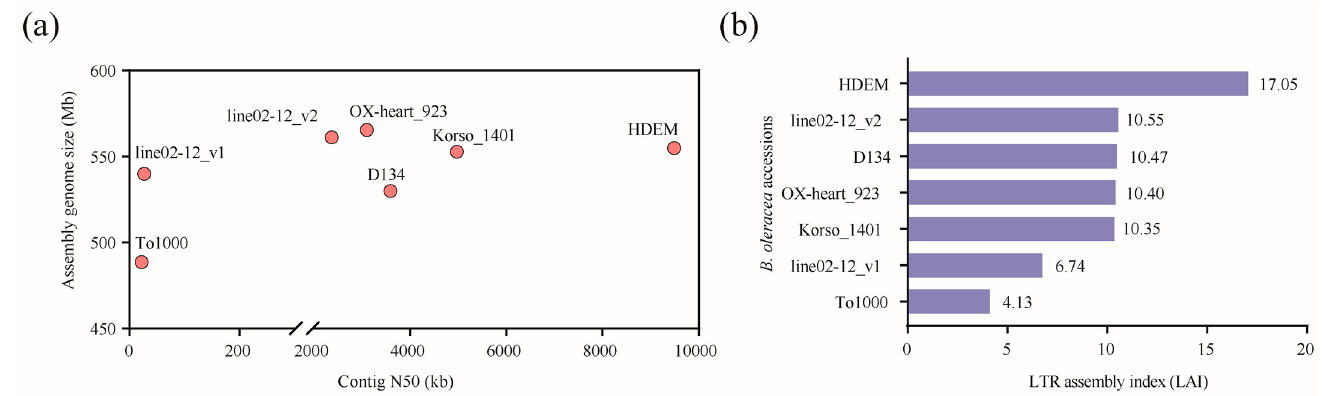
Figure 1. Comparison of assembly genome sizes, contig N50 ( a ), and LAI ( b ) of six Brassica oleracea genomes.